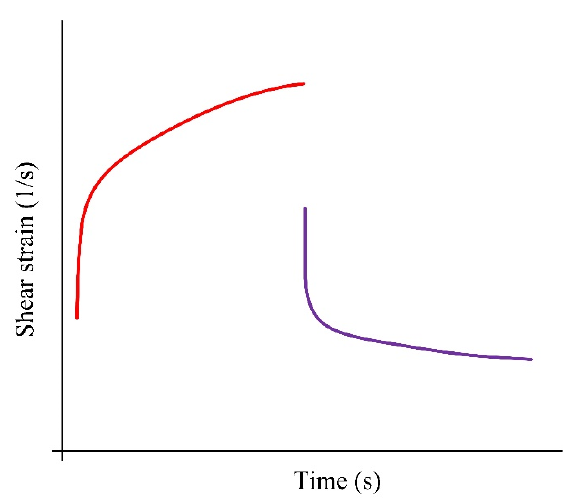
Figure 6. Type of typical dependences in the study of creep of gel fuel